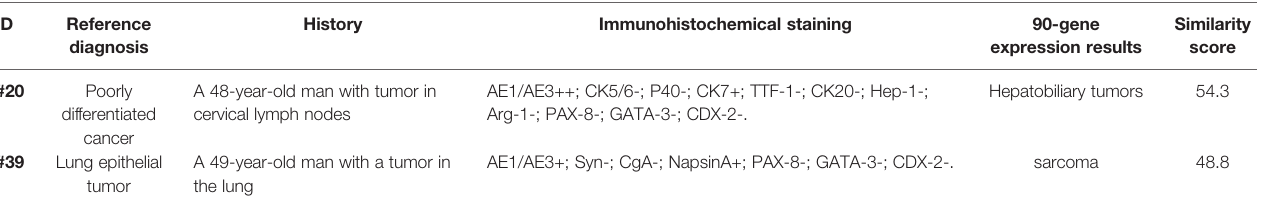
TABLE 2 | Investigation of cases with discordant 90-gene